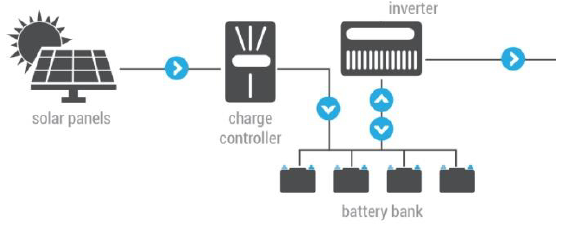
Fig 16. Solar-powered UAV